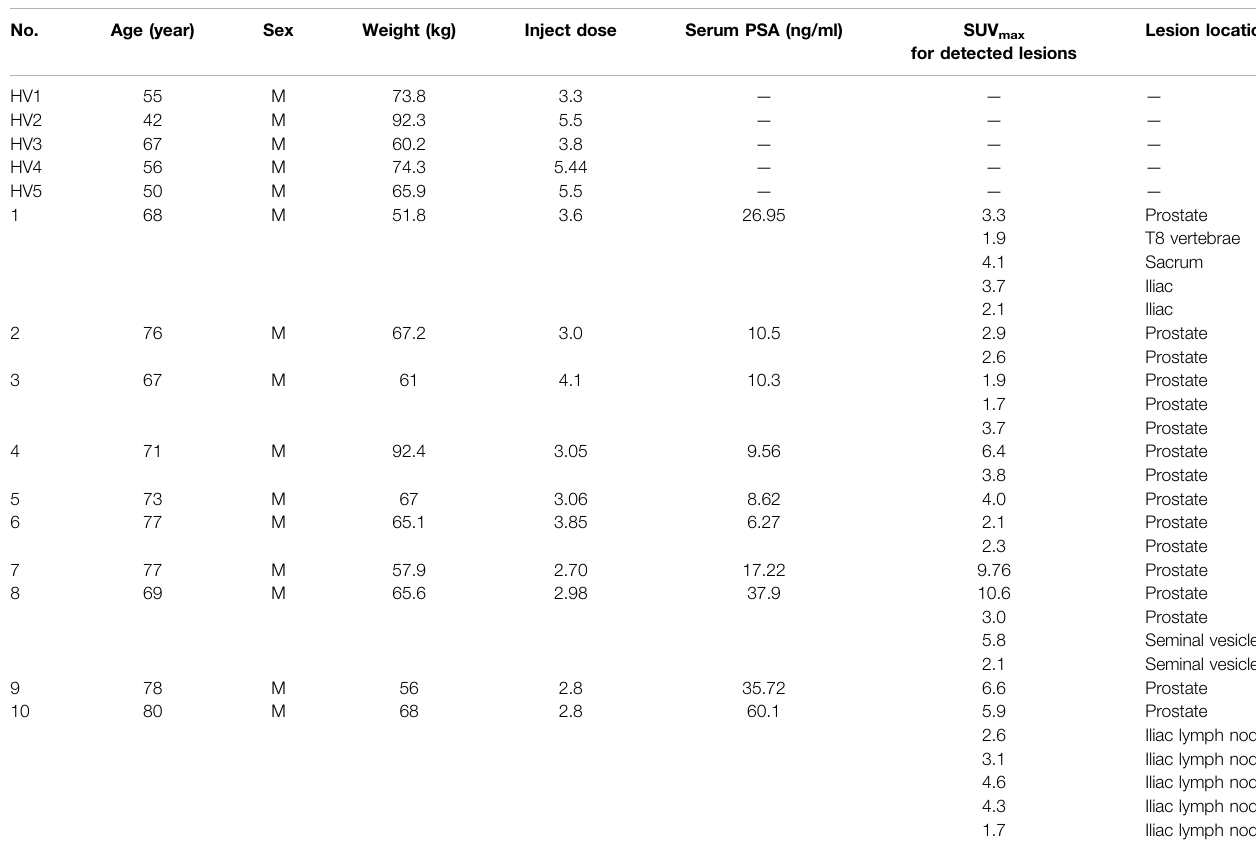
Note. PSA, prostate-speci fi c